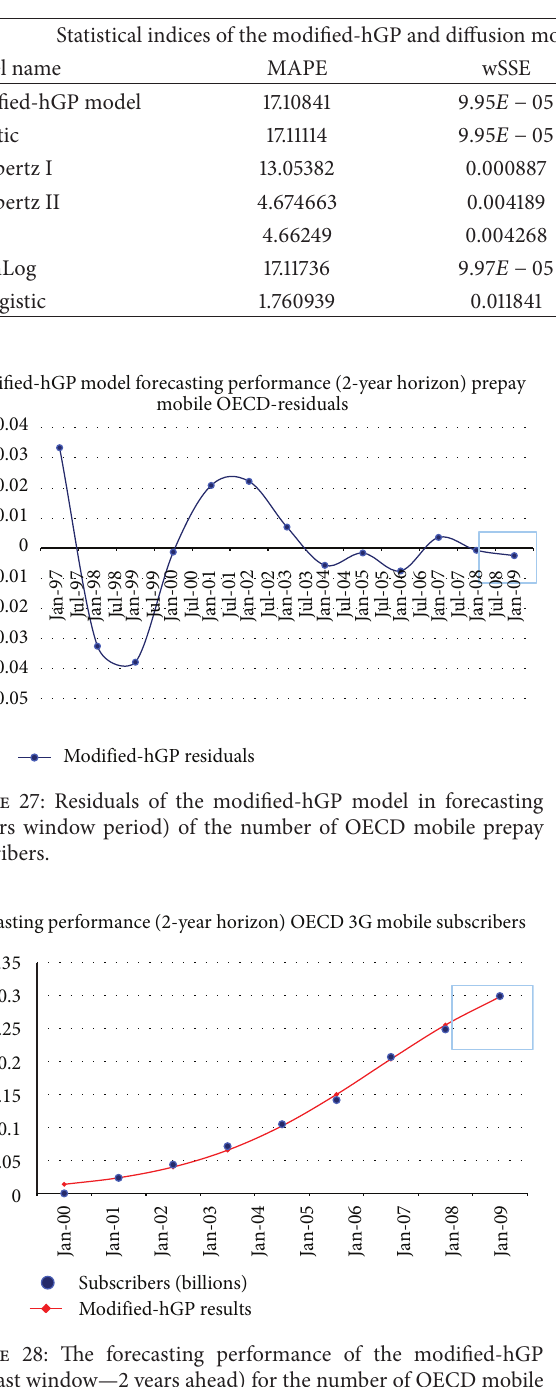
Table 10: Statistical indices in forecasting process of the modified-hGP and diffusion models for the number of OECD mobile 3G subscribers.